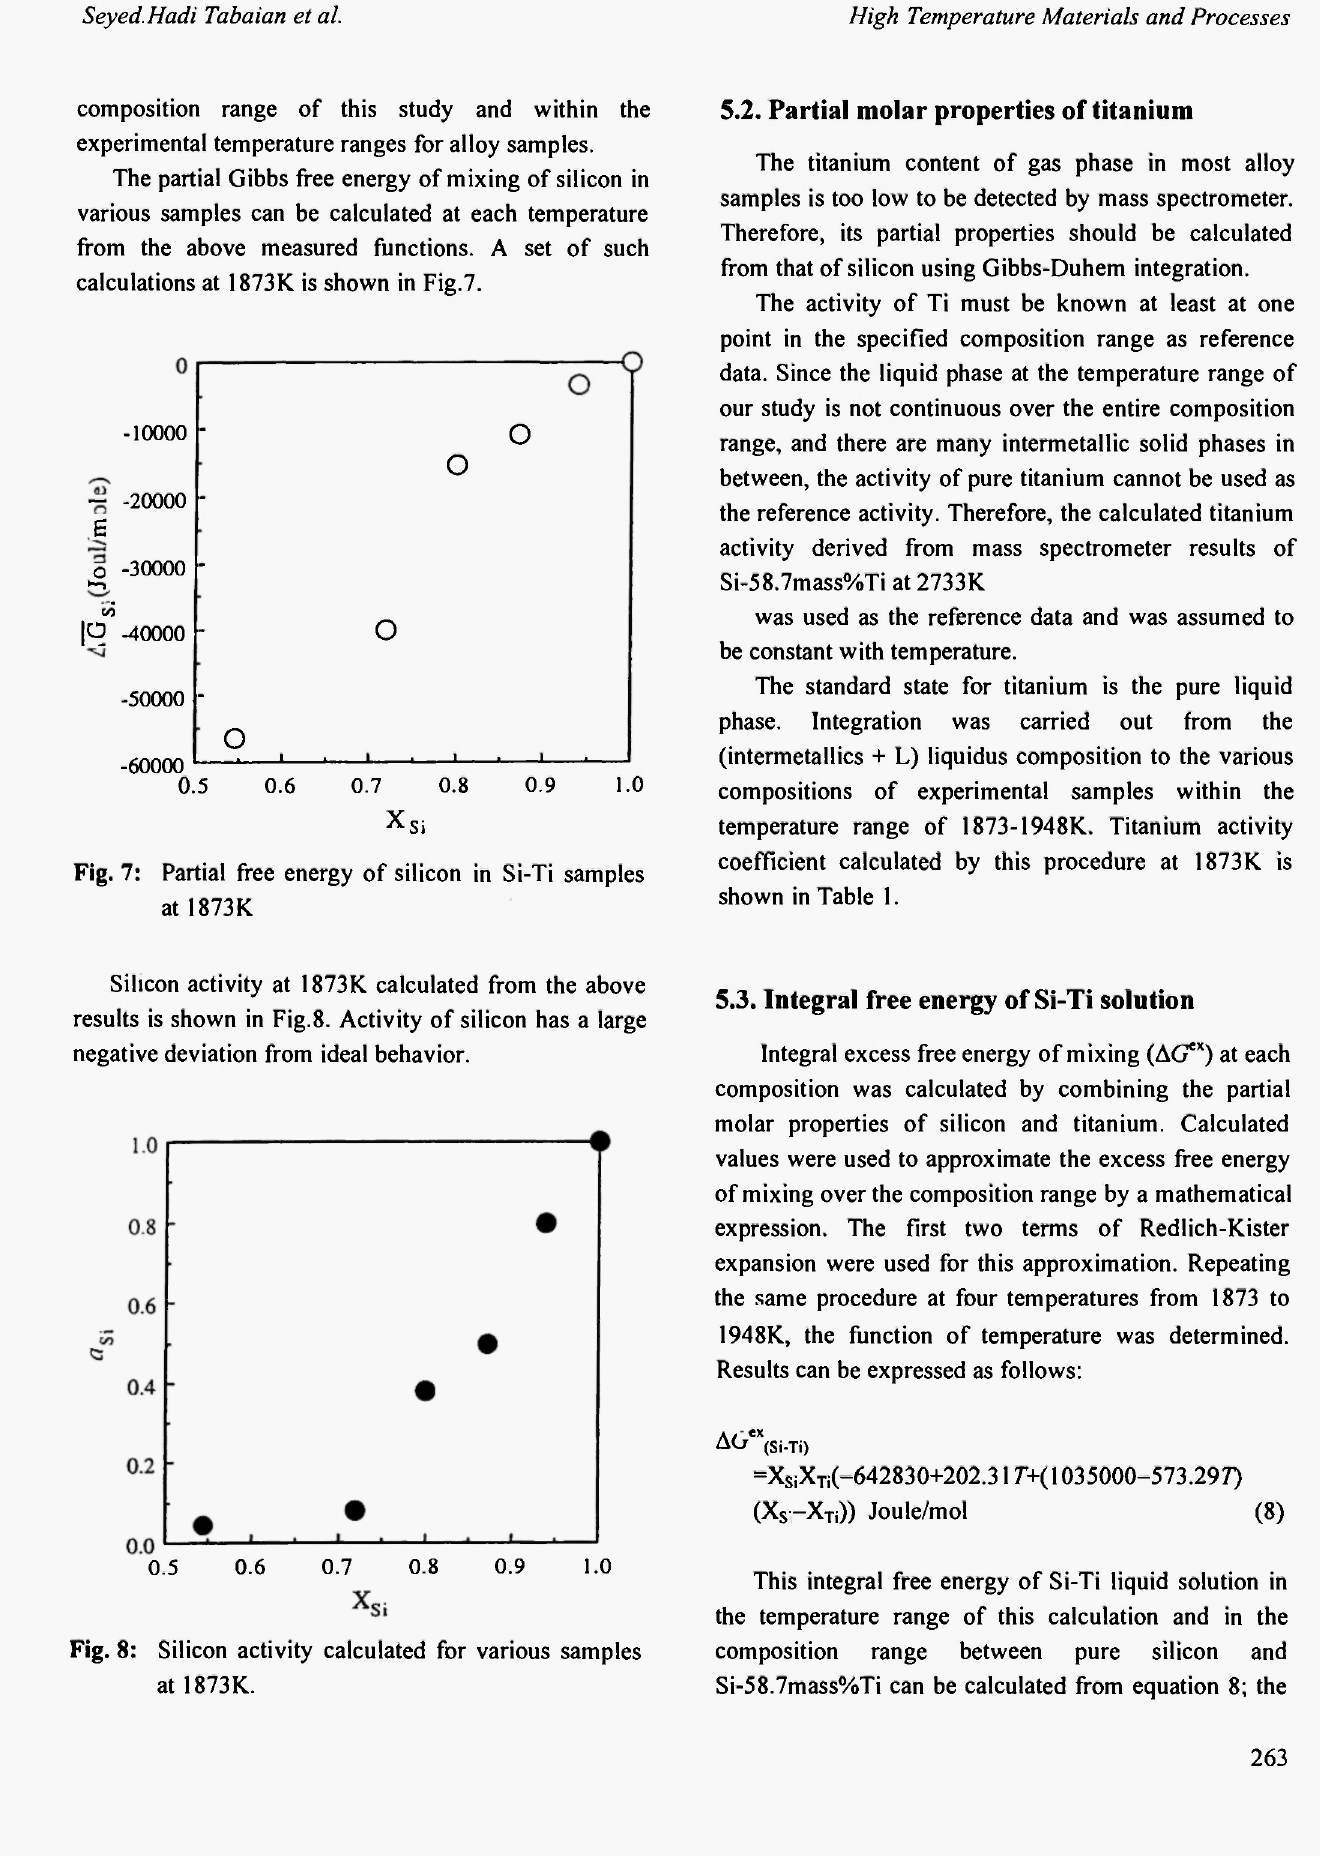
Fig. 7: Partial free energy of silicon in Si-Ti samples